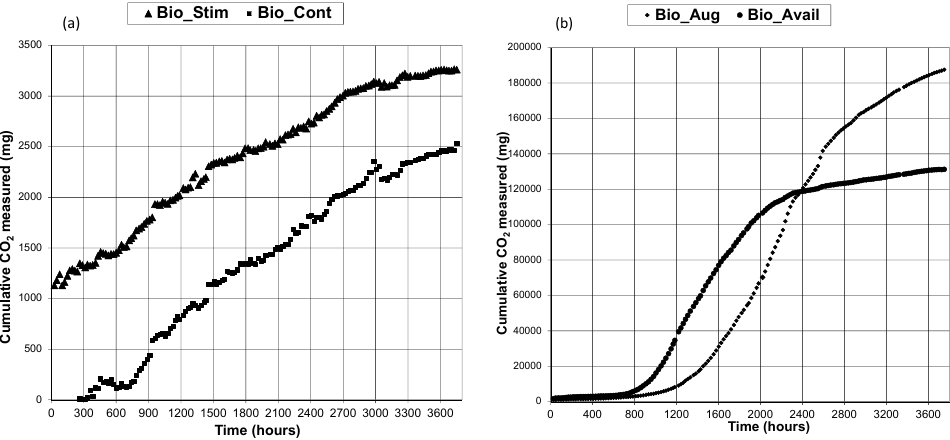
Figure 1. Combined cumulative CO 2 generation ( a ) Bio_Cont and Bio_Stim ( b ) Bio_Aug and Bio_Avail.